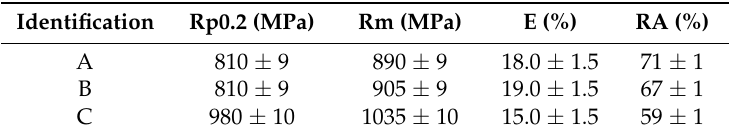
Table 3. Verification of the strength grade of the three materials, including the extended uncertainty for each measurement (K = 2).